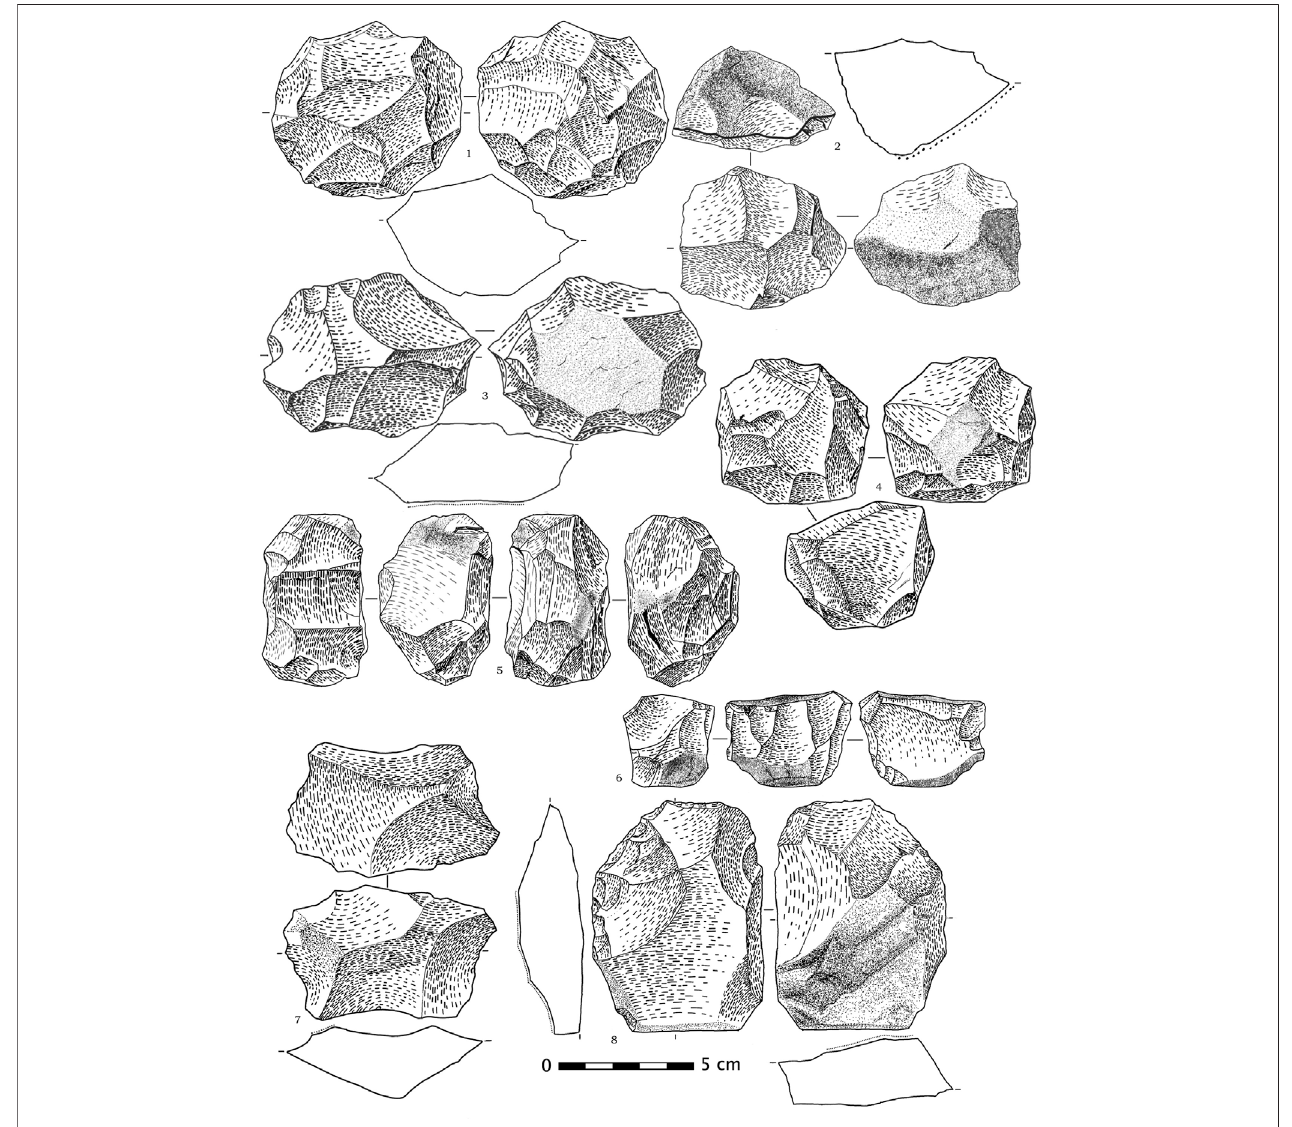
FIGURE 5 | Cores. Discoidals: bifacial (1), unifacial (2) and discoidal with differentiated striking platform (3); multipolar (4); peripheral monopolars (5, 6); bifacial on fl ake (7), and bifacial on fl ake retouched (8). All on quartzite.